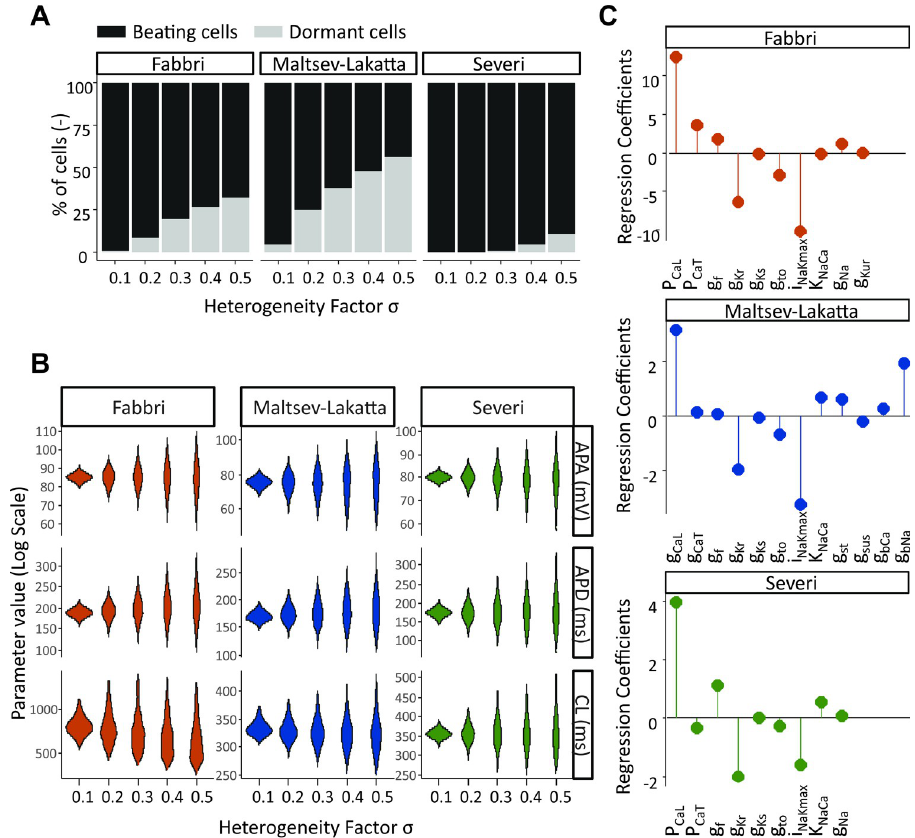
Fig 4. Modeling conductance heterogeneity using virtual populations of isolated SAN cells. (A) The effect of heterogeneous ionic channel expression on the automaticity of SAN cells was compared across models. In all three models the percentage of dormant cells rose with increasing levels of heterogeneity. (B) The effect of heterogeneity on the SA node AP properties was evaluated in spontaneously beating cells, by measuring cycle length (CL), AP amplitude (APA) and AP duration (APD) at varying σ levels. Outliers (values more than three median absolute deviations) were removed from distributions. (C) Logistic regression analysis was utilized to deduce which specific ionic currents across the three models are responsible for SA node cell’s automaticity. Positive values indicate that an increase in the parameter increases the probability of the cell to be spontaneously beating.